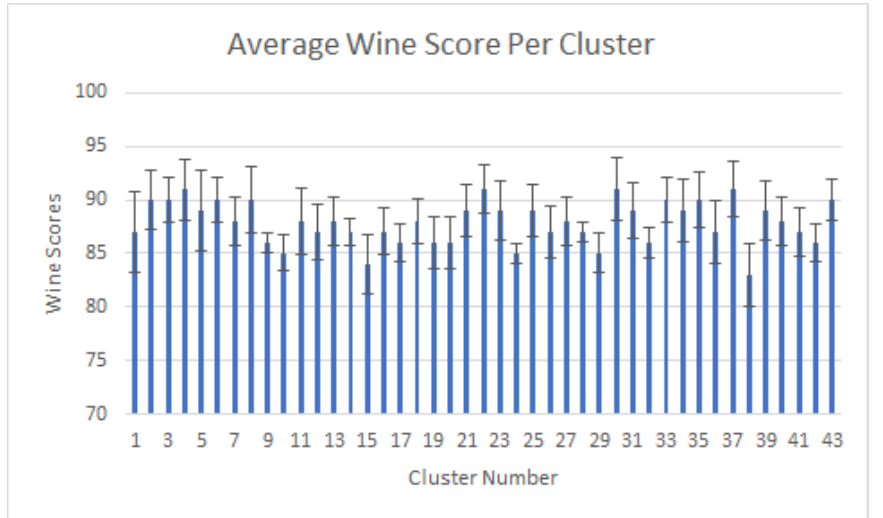
Figure 10. Average wine scores (±SD) per cluster with standard deviation. As the wine scores are not utilized when clustering the wines due to the focus on keywords within wine reviews, the wine scores given at the optimum cluster value (K = 43) are better utilized as a means of reflection as to which common attribute combination (Figures 8 and 9) has better results.